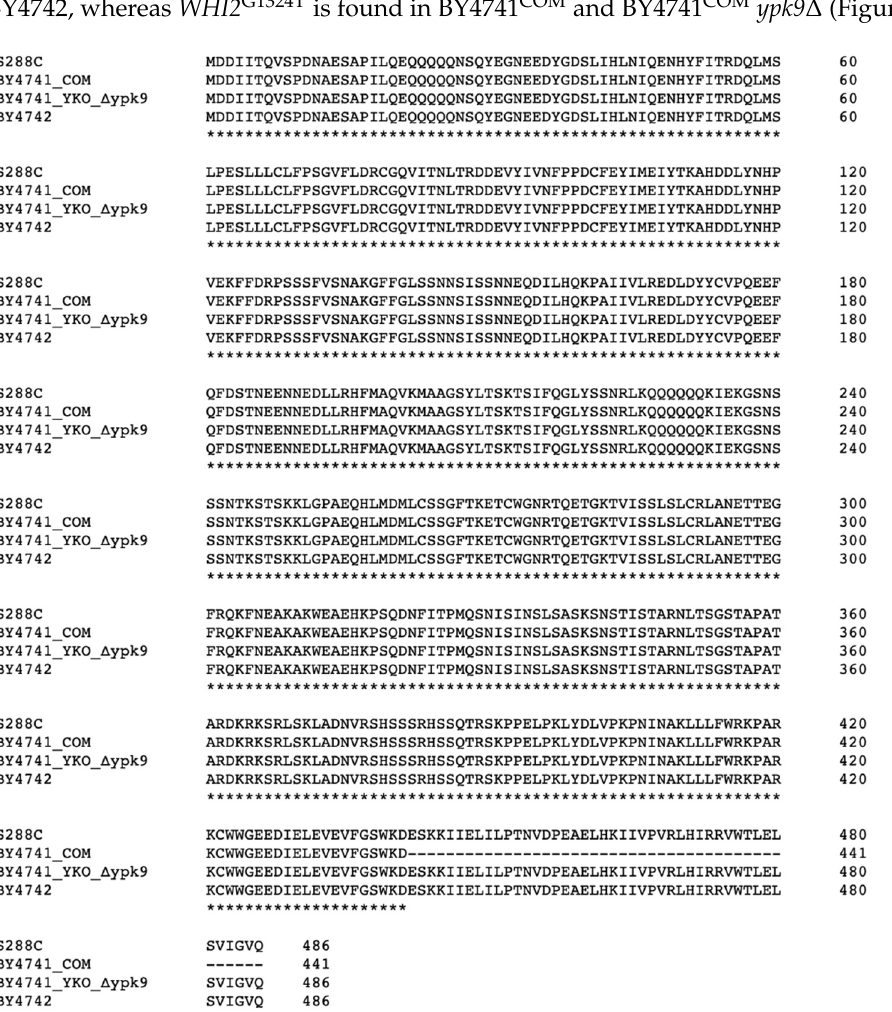
Figure 2. Alignment of Whi2p variants. The reference strain (S288C), BY4742, and YKO collection’s ypk9 ∆ contain the sequence for full-length Whi2p (486 amino acids). In contrast, BY4741 COM ’s WHI2 sequence has a premature stop codon yielding a truncated Whi2p of 441 amino acids residues. Clustal Omega was used to align sequences [29].